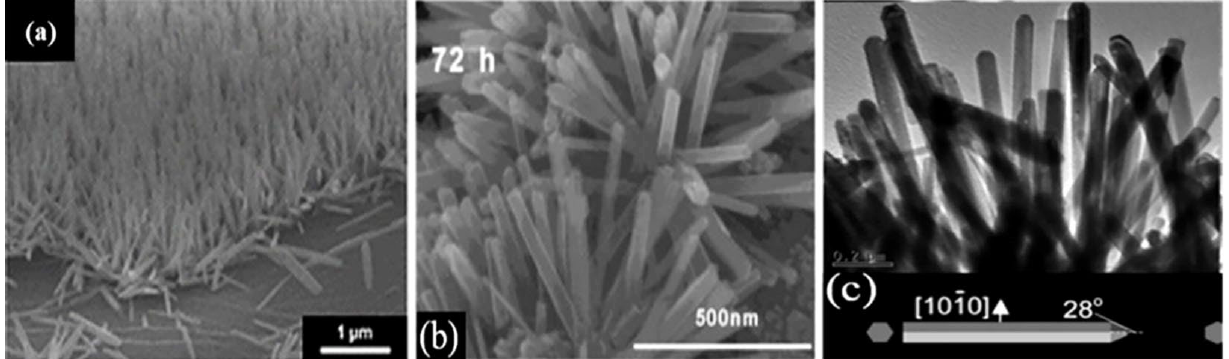
Figure 5. Examples of solution-synthesized nanostructures: ( a ) 600 tilted cross-sectional FE-SEM images of vertical ZnO NWs grown on a reduced graphene/PDMS substrate. Reprinted with permission from the Royal Society of Chemistry (Ref. [116]); ( b ) HR-TEM image of SnO 2 nanorods. Reprinted with permission from Ref. [123]; ( c ) TEM images of ZnO nanorods. Reprinted with permission from Ref. [122].